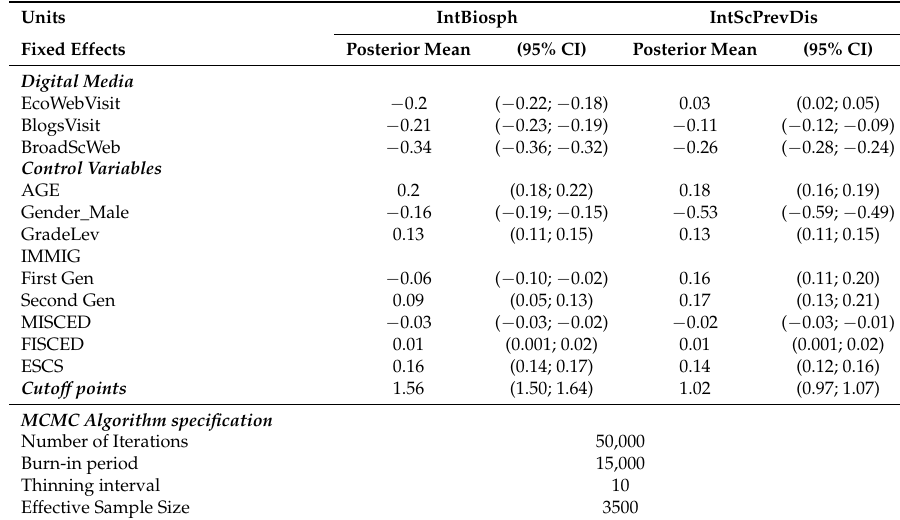
Table A6. MCMC estimates of the fixed effects along with their 95% CI for the BOP model of students